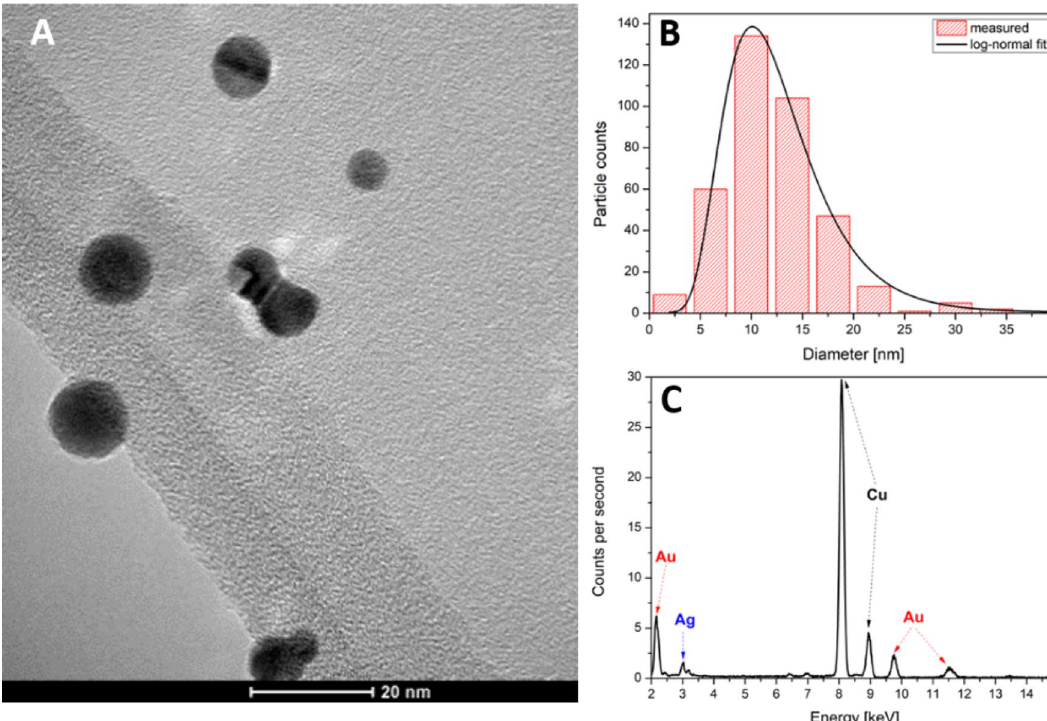
Figure 1. Morphology ( A ), size distribution ( B ), and EDX spectrum ( C ) of Au/Ag BNPs generated in the SDG (1 Ω total resistance, initially anodic Au electrode, 900 °C compaction